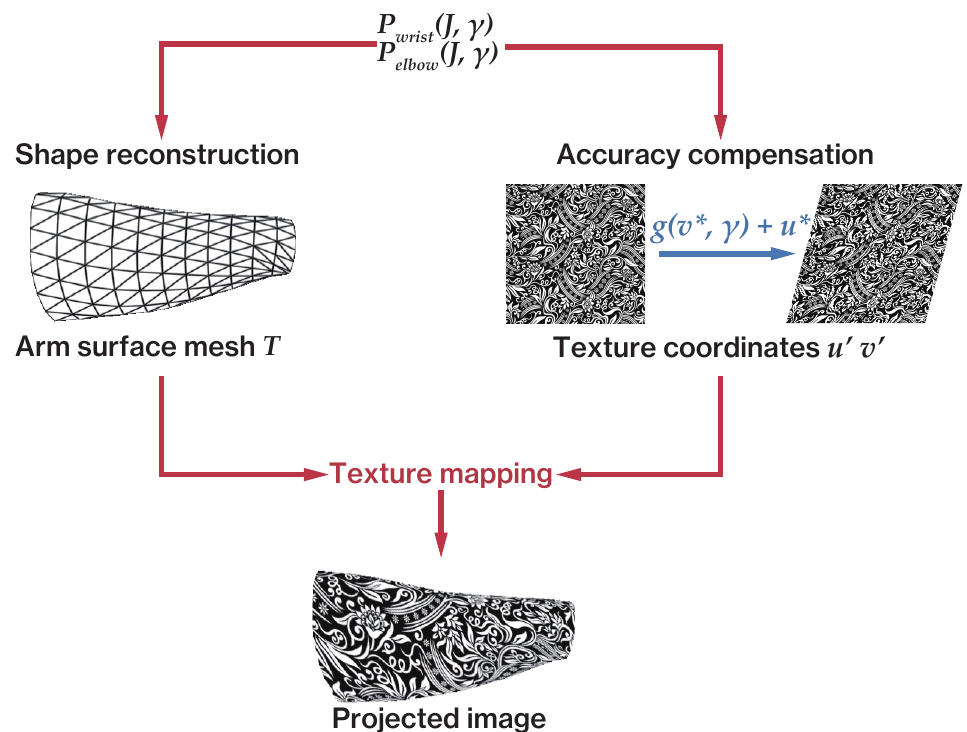
Figure 3. Shape reconstruction and compensation executed in parallel using joint tracking